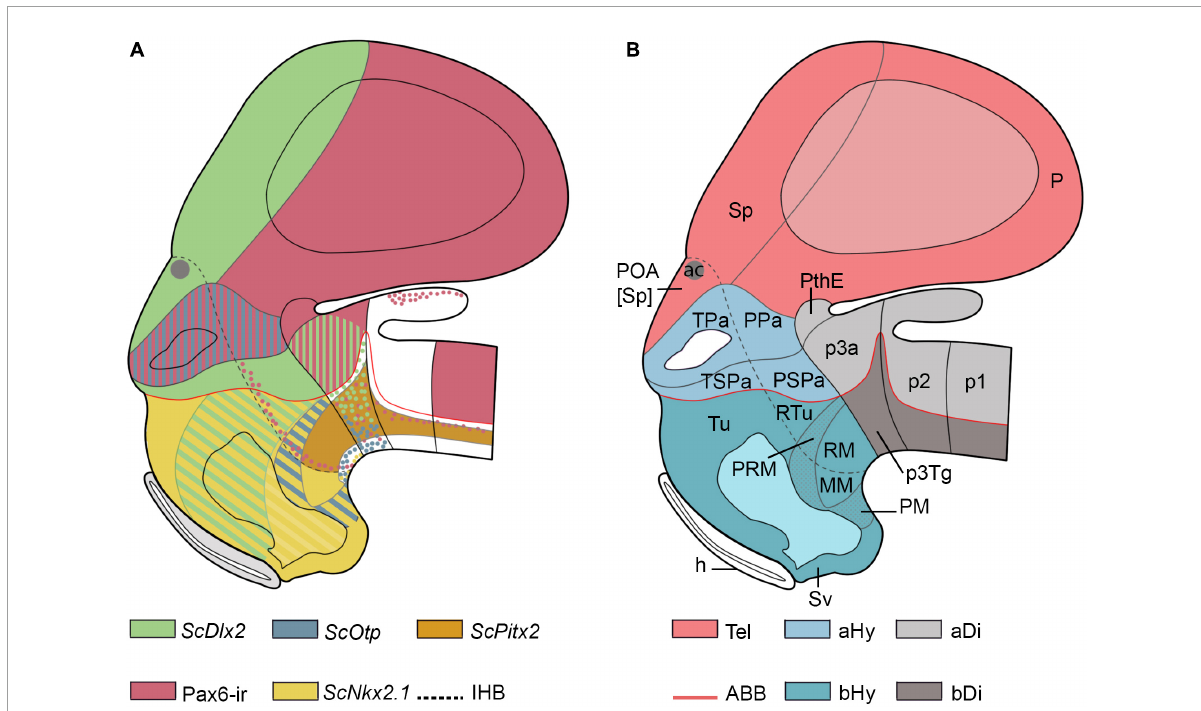
FIGURE1 Schematic representations of the forebrain organization in Scyliorhinus canicula embryos at stage 29 according to previous genetic neuroanatomical data following the prosomeric model. (A) Schematic representation of ScOtp- , ScDlx2- , ScNkx2.1- , ScPitx2 -expression and Pax6-ir structures in the secondary prosencephalon and surrounding tissues according to Santos-Durán et al. (2015, 2016, 2018). (B) Schematic representation of the segmental organization of the prosencephalon and main histogenetic domains of the secondary prosencephalon according to Santos-Durán et al. (2015, 2016, 2018). The boundary of the acroterminal region was not represented, but this region includes the pre-optic area, the pre-optic recess, optic stalk and eye vesicle, the optic chiasma, the tuberal median eminence, the acroterminal part of the infundibulum, and the neurohypophysis and ends at the mamillary body. (For abbreviations, see